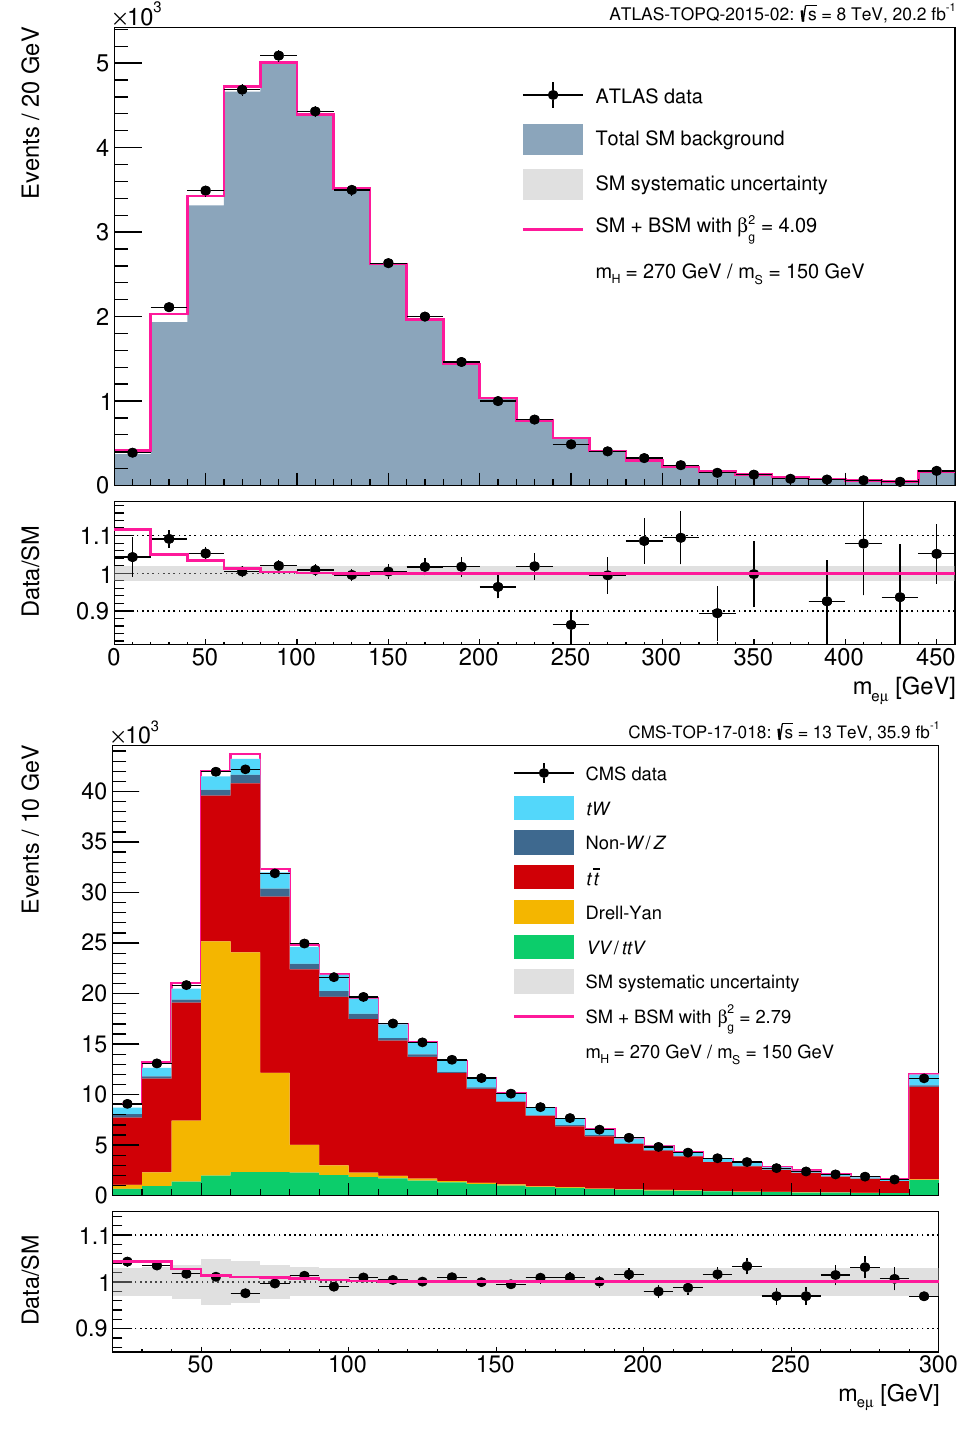
Figure 3 . The SM+BSM (cid:12)t result for the di-lepton invariant mass spectrum reported by ATLAS in Run 1 (above) and CMS in Run 2 (below). In each case, (cid:12) 2 The SM predictions and systematic uncertainties do not incorporate the constraints imposed by the